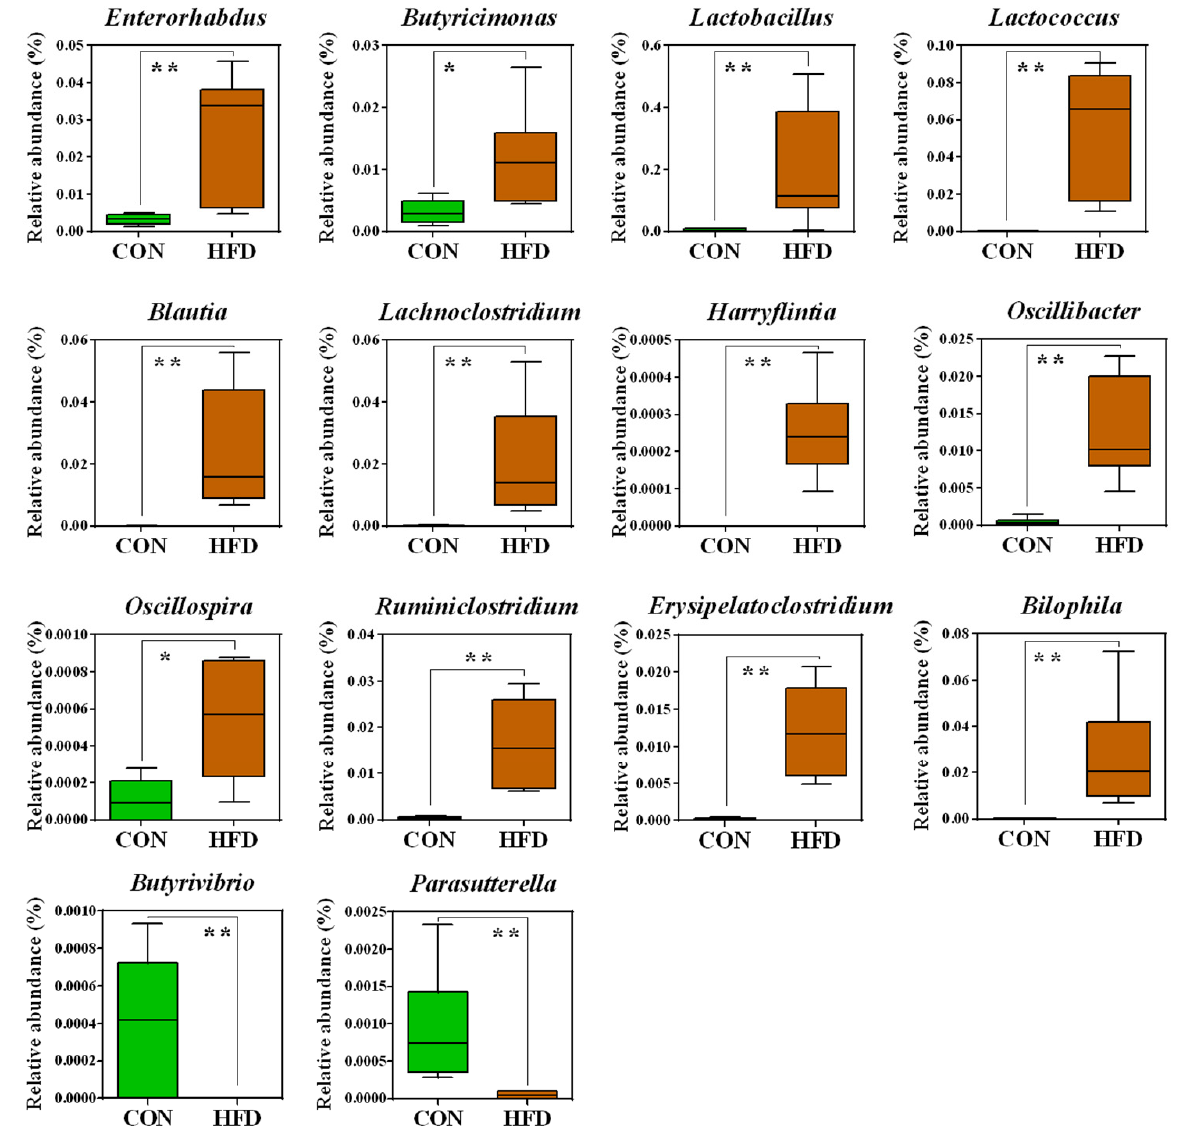
Figure 3. Box plots of significantly different microorganisms at the genus level in the guts of the HFD and control groups. The p -values were obtained using Mann–Whitney U tests. *, p < 0.05; **, p < 0.01. A false discovery rate of 5% was applied to all tests to correct for multiple testing.